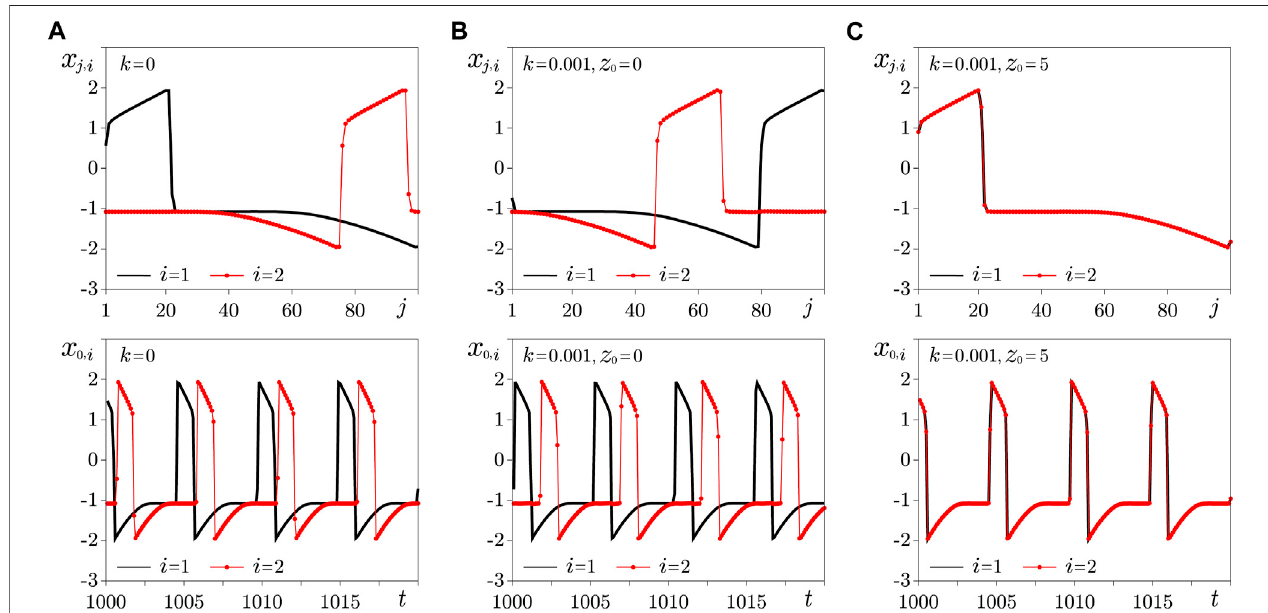
FIGURE 1 | Pro fi les of traveling waves (upper row) and oscillations x 0, i ( t ) (lower row) in two identical rings (2) in the absence of interlayer coupling k = 0 (A) ; with coef fi cient k = 0.001 for different initial values of memristive variables z 0 = 0 (B) and z 0 = 5 (C) . Parameters: σ 1 = σ 2 = 4.5, δ = 0.